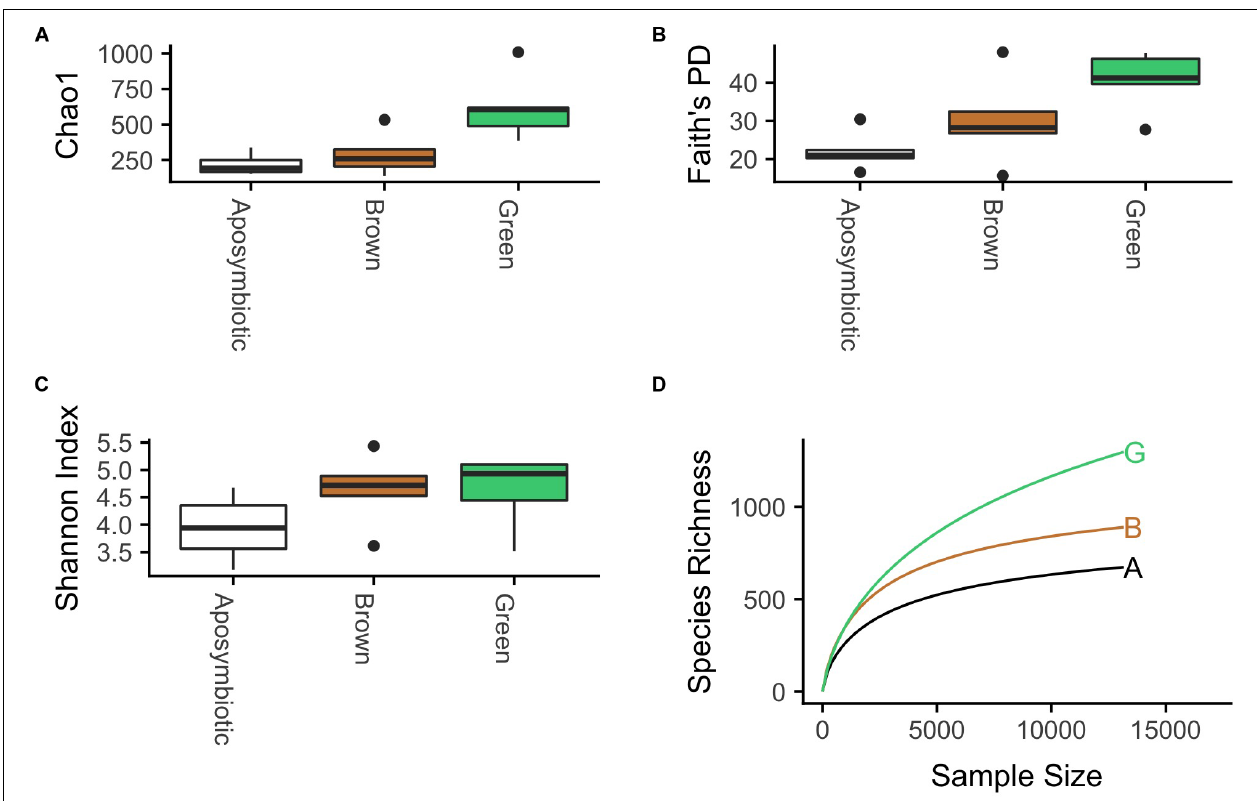
FIGURE 2 | Microbial communities associated with the green symbiotic state have significantly higher median (A) Chao1 (Mann–Whitney U, p = 0.003) and (B) Faith’s PD values (Mann–Whitney U , p = 0.039). There is some evidence that communities associated with symbiotic anemones have higher median (C) Shannon index values than those of aposymbiotic anemones (Mann–Whitney U , p = 0.055). (D) Rarefaction curves of aggregated samples ( n = 5 for each symbiotic state) provide estimates of the total number of OTUs observed in communities associated with each symbiotic